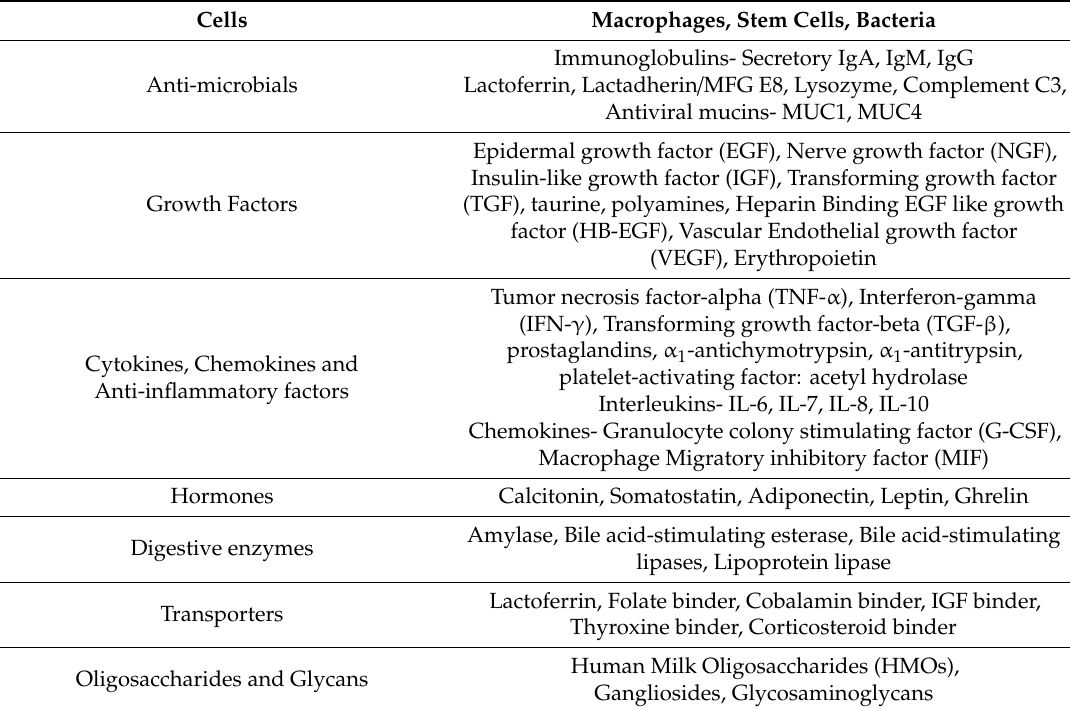
Table 3. Bioactive factors in the maternal